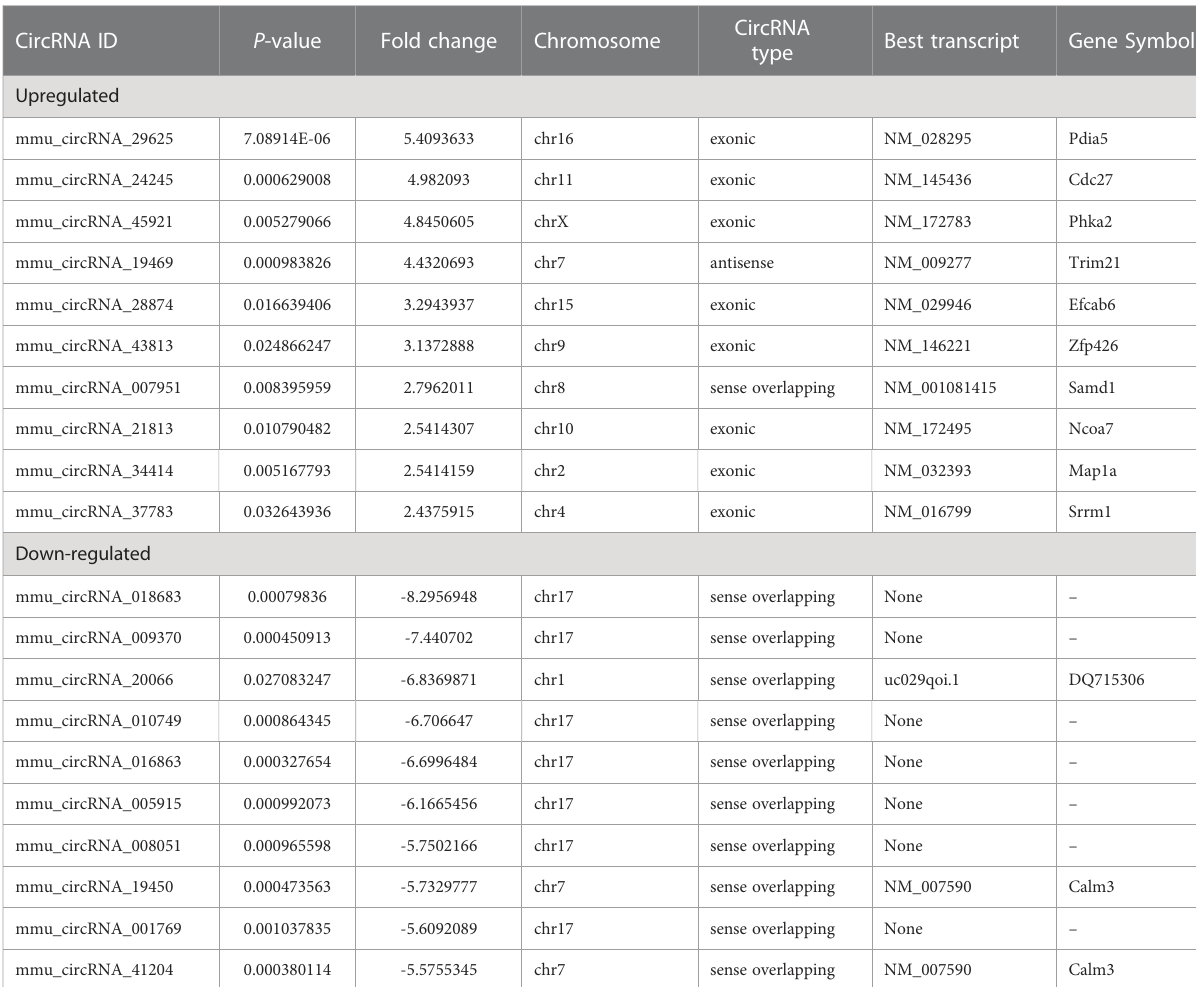
TABLE 2 Biological information for the top 10 upregulated and downregulated circRNAs.